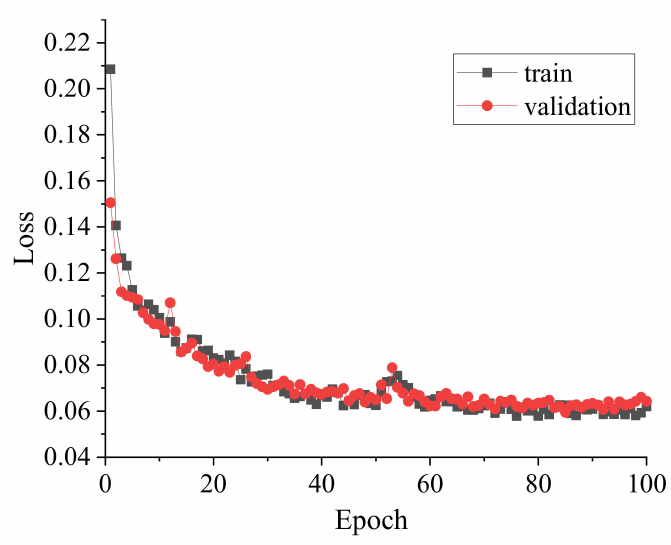
Figure 1. Semantic segmentation network.